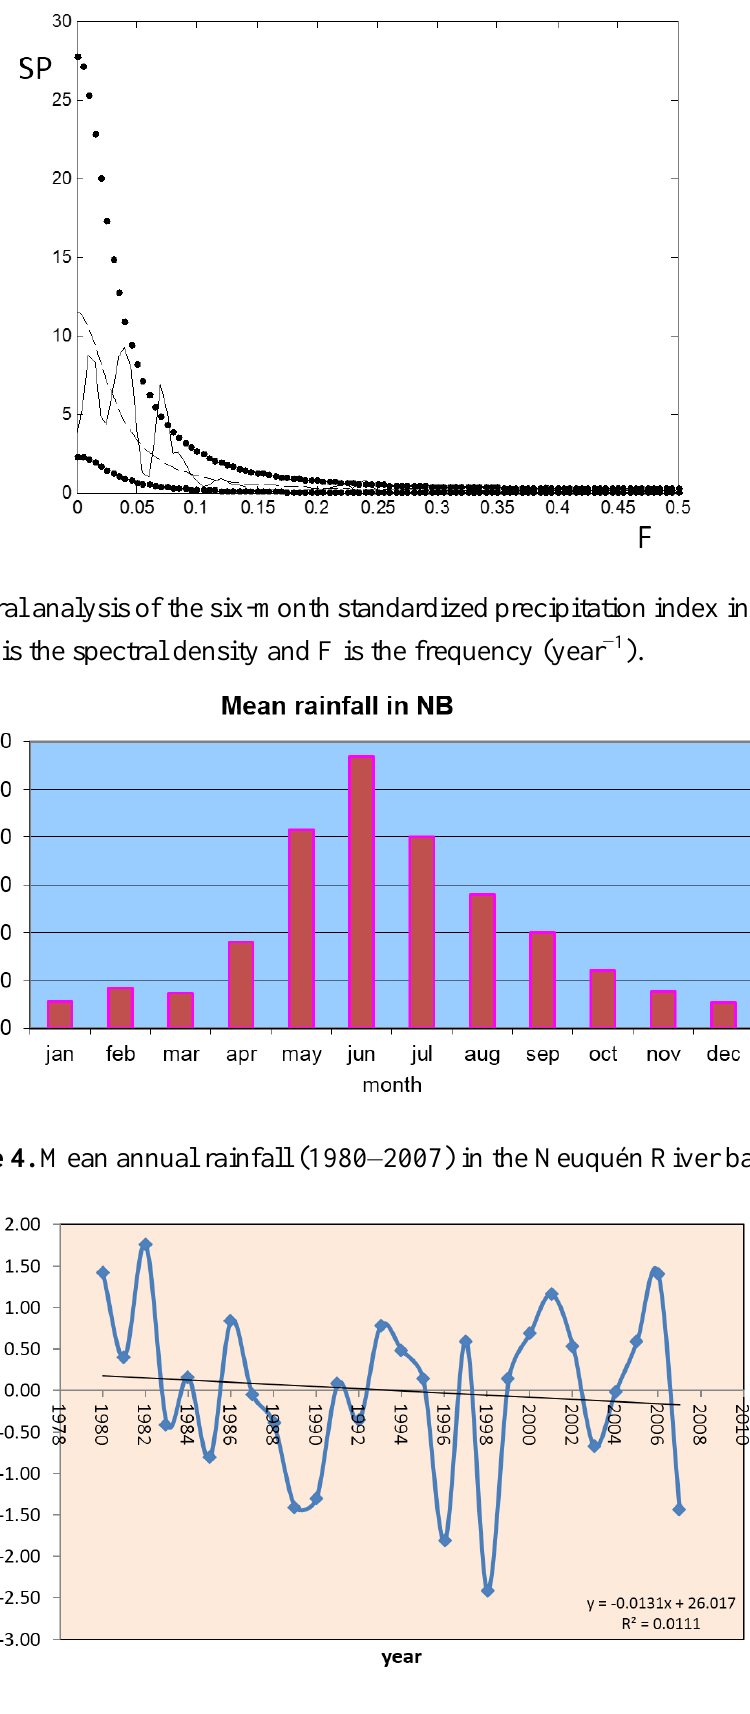
Figure 5. Evolution of six-month-standardized precipitation index in September in the Neuquén river basin. Linear trend in